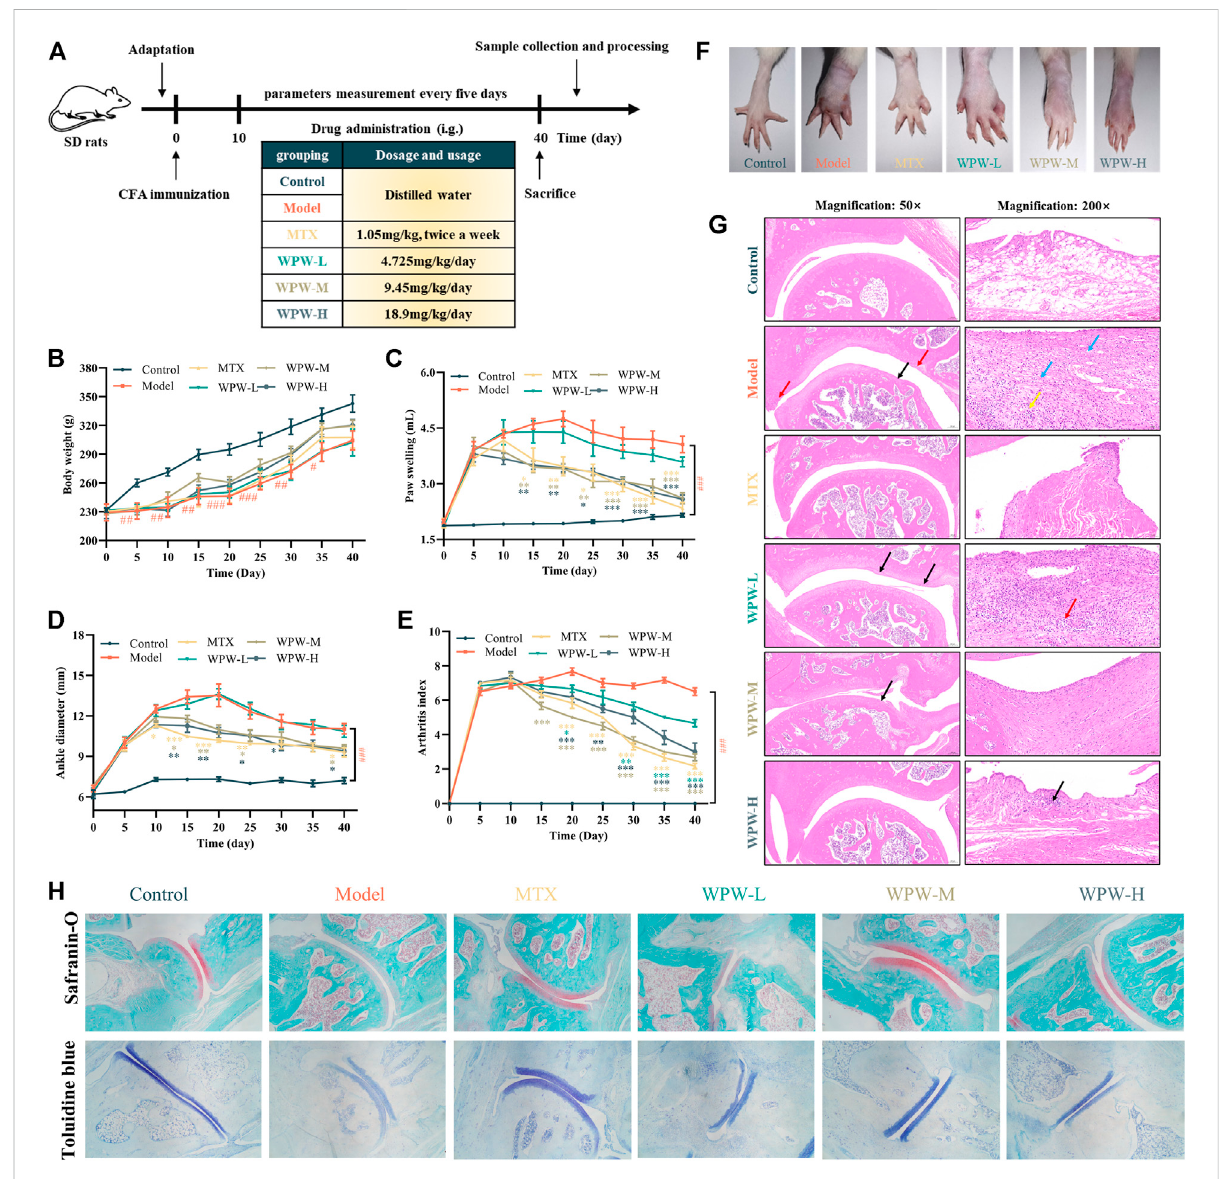
FIGURE 4 Effect of WPW on the pathological process of RA in AA model rats. (A) Experimental schedule of WPW on AA model rats. The arthritis index (B) , paw swelling (C) , ankle diameter (D) , and body weight (E) in AA rats (n = 6). (F) Representative images of the hind limbs of the different treatment groups at theend of the experiment. (G) Histopathological evaluation of the ankle joints of rats indifferent treatment groups was conducted by H&E staining (n = 3; Magni fi cation: ×50 and ×200; Scale bar: 200 and 50 μ m). (H) Safranin-O and toluidine blue staining (n = 3; Magni fi cation: